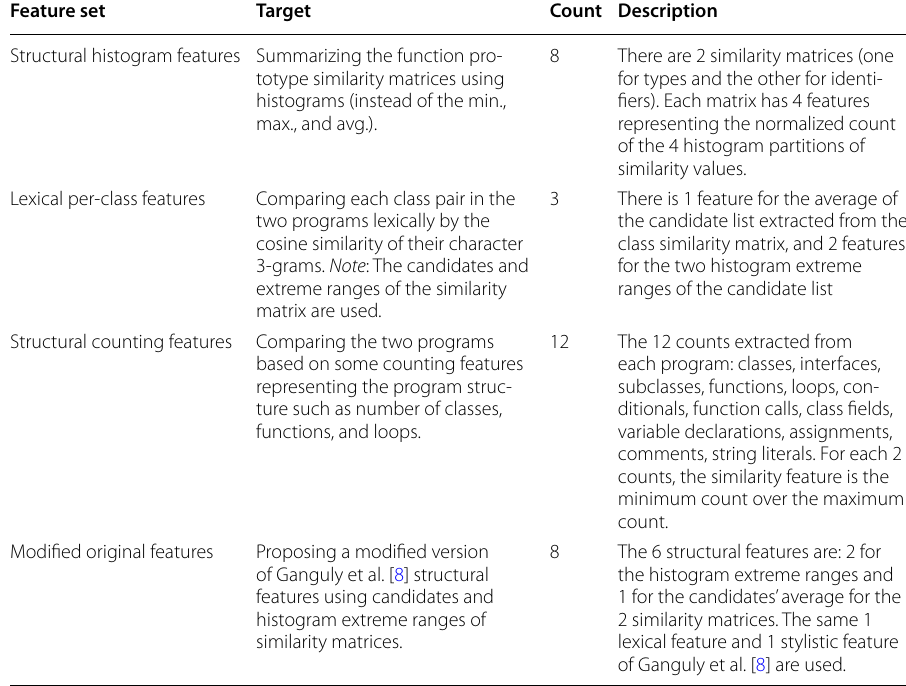
Table 3 The target and description of the proposed feature sets Feature set Target